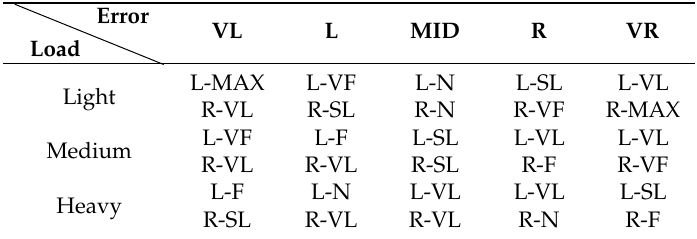
Figure 17. Structure of proposed fuzzy controller.